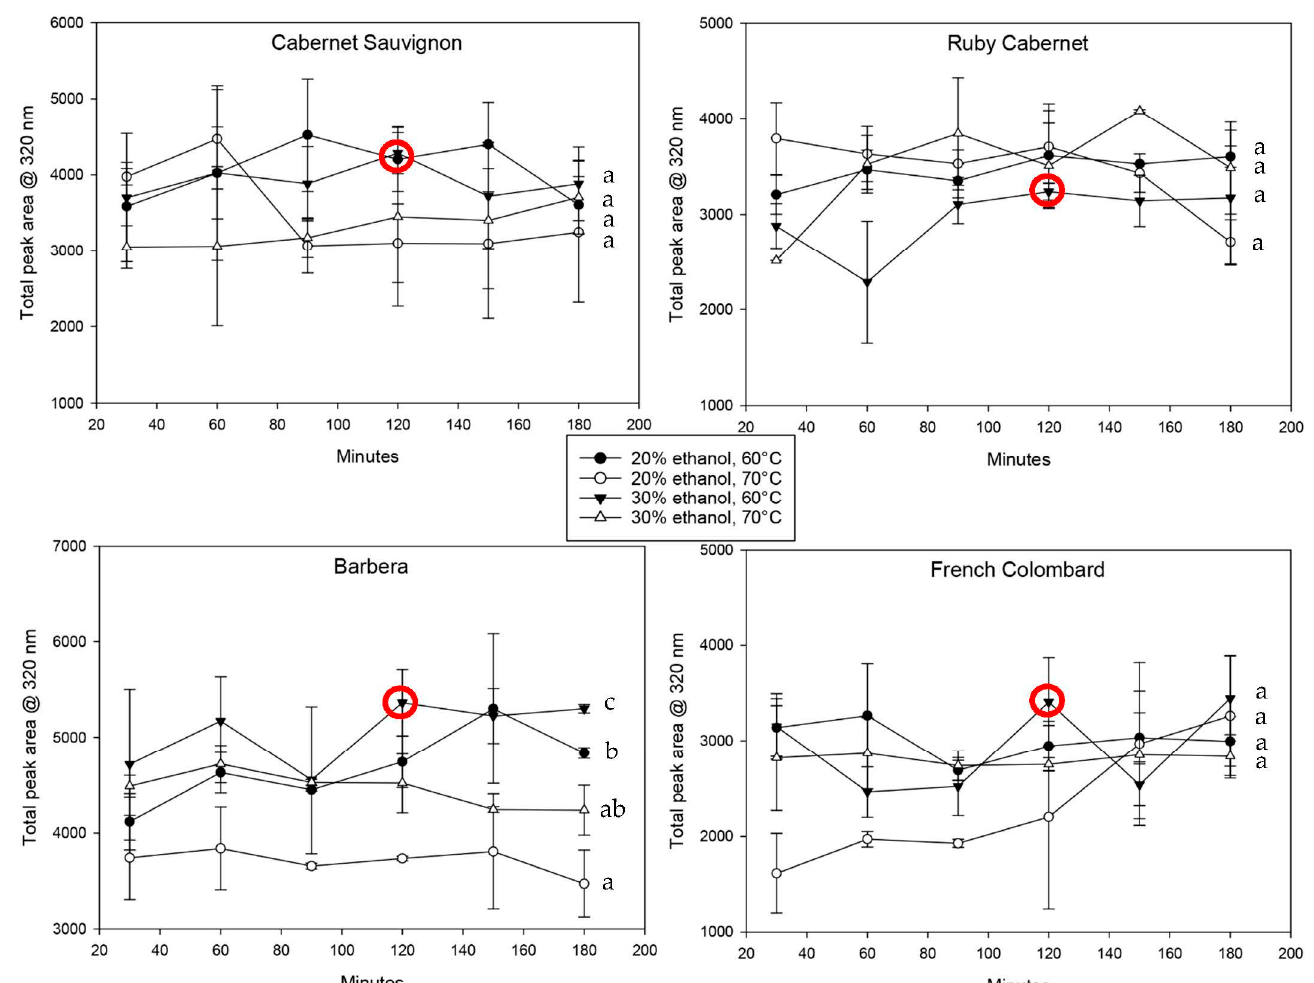
Figure 4. Liquid chromatography analysis of the monomeric phenolic material in leaf tissue extracts over time at 320 nm. Extracts are shown for four cultivars using different temperature-solvent strength combinations. The red circle indicates the extraction conditions that were chosen for the proposed method. Statistically significant differences ( p < 0.05) within each dataset are indicated using le tt ers a, b, c.